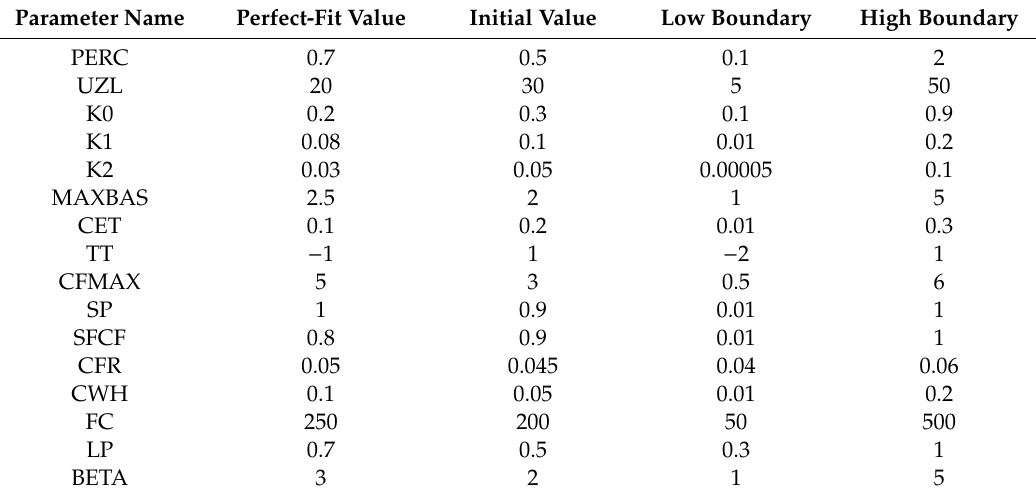
Table 2. The values of initial parameters and boundary